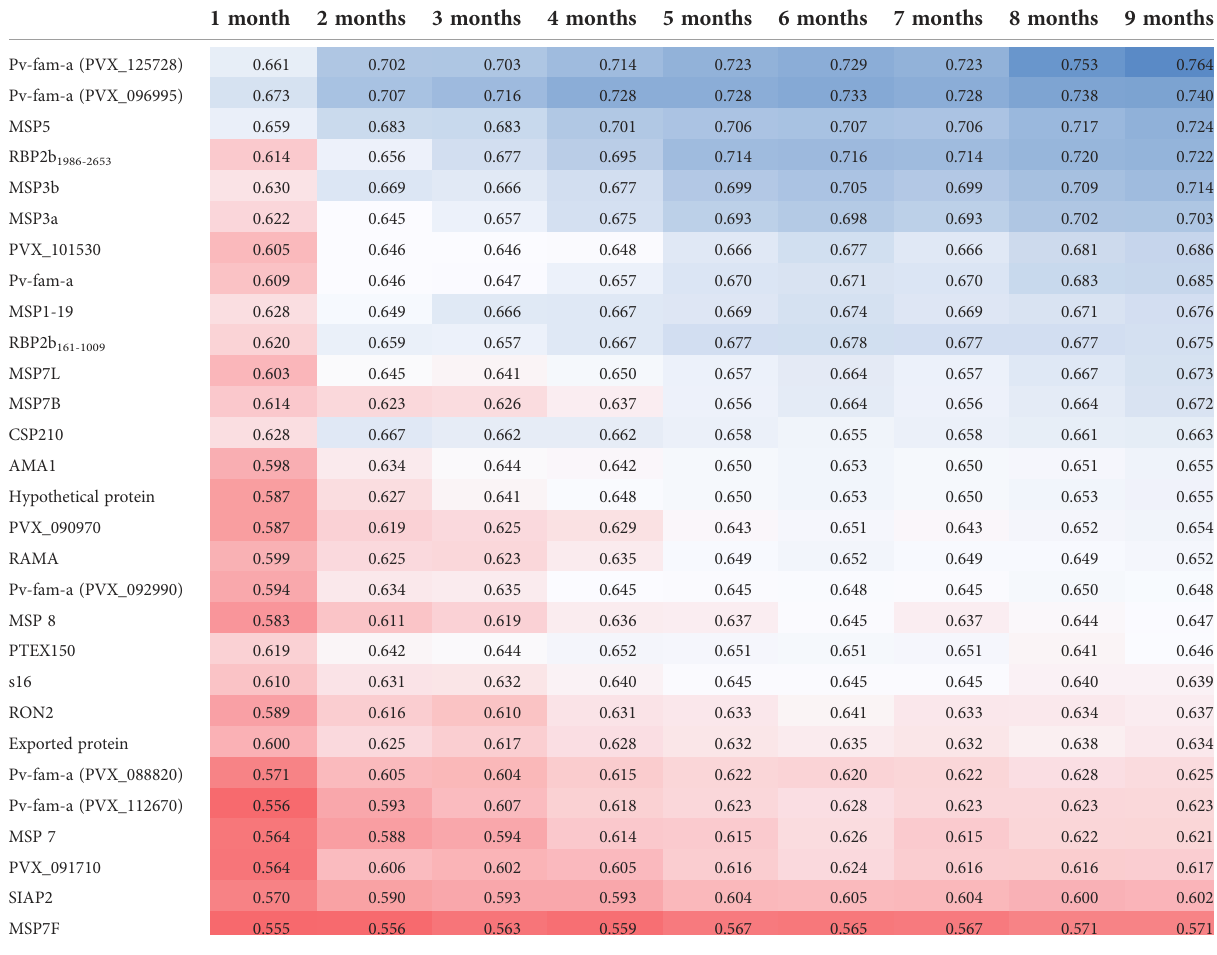
The two color scheme highlights the lowest AUC values in red and the highest AUC values in